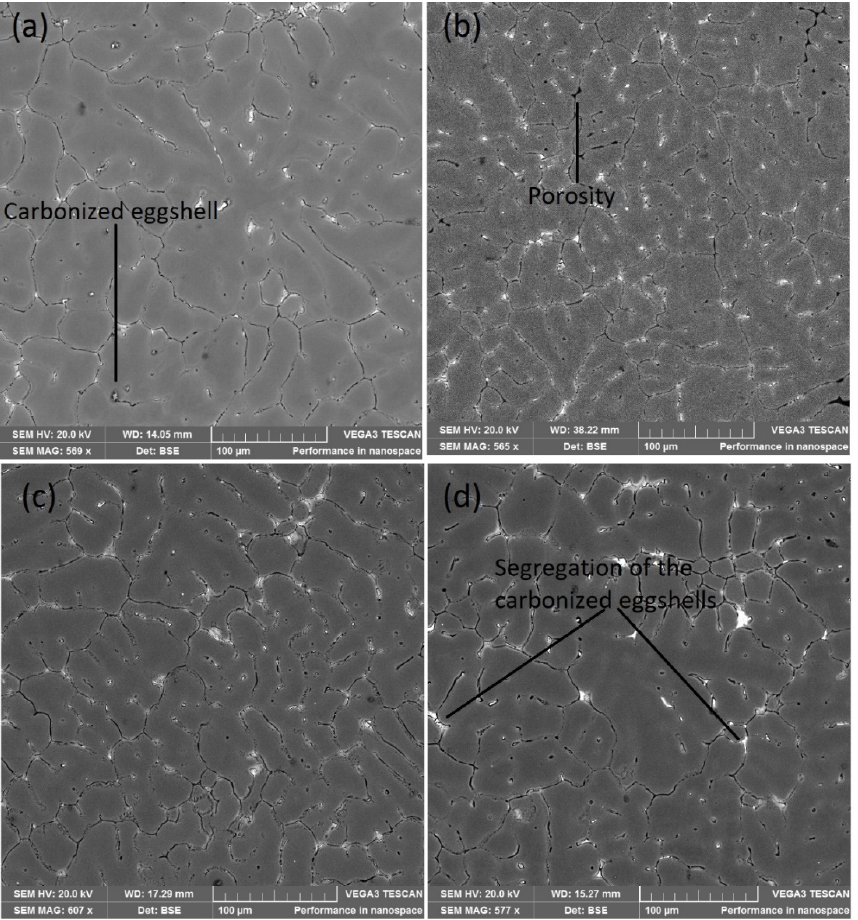
Figure 1. SEM morphology of the cast AMCs. ( a ) C1 (900 °C); ( b ) C2 (900 °C); ( c ) C3 (1100 °C); ( d ) C4 (1200 °C).